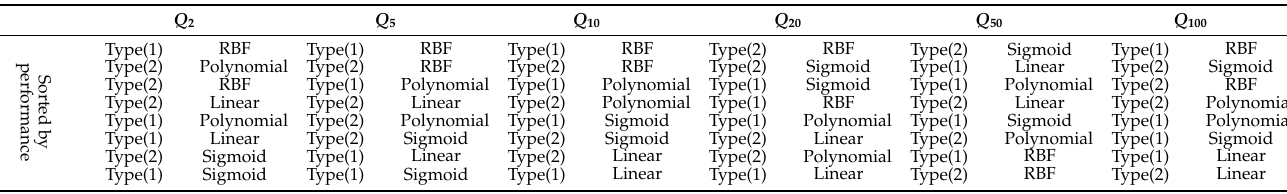
Table A3. Best-performing SVM models for different flood